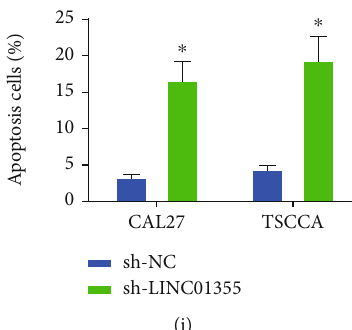
Figure 1: Loss of LINC01355 inhibited OSCC cell proliferation and induced cell apoptosis. (a) The expression of LINC01355 mRNA was detected by RT-qPCR analysis in HOMEC, CAL27, SCC-15, TSCCA, Tca8113, SCC-9 cells. (b, c) mRNA expression of LINC01355 was detected in CAL27 cells and TSCCA cells when transfected with several shRNAs of LINC01355. (d, e) The cell viability of CAL27 cells and TSCCA cells was analyzed after transfection with shRNA for LINC01355 for 1, 2, 3, and 4 days by CCK8 assay, respectively. (f, g) The cell proliferation of CAL27 cells and TSCCA cells was analyzed after transfection with the speci fi c shRNA for LINC01355 by using EdU assay. (h) The cell colony formation capacity of CAL27 cells and TSCCA cells was analyzed using colony formation assay. (i) The cell apoptosis of CAL27 cells and TSCCA cells was analyzed using fl ow cytometry assay. ∗ p < 0 : 05